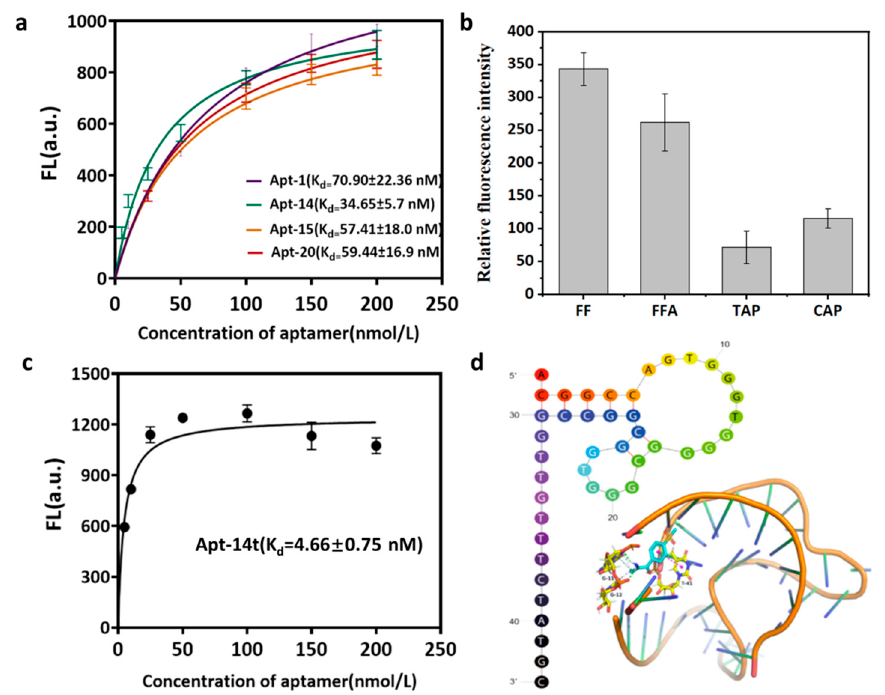
Figure 2. ( a ) The saturation curves and K d values of Apt-1, Apt-14, Apt-15, and Apt-20. ( b ) Relative fluorescence intensity of Apt-14t in the presence of florfenicol, florfenicol amine, chloramphenicol, and thiamphenicol. ( c ) The nonlinear regression analysis of Apt-14t (0–200 nmol L − 1 ) for evaluation of K d values. ( d ) Secondary structure of the truncated aptamers and molecular docking of Apt-14t and FF.